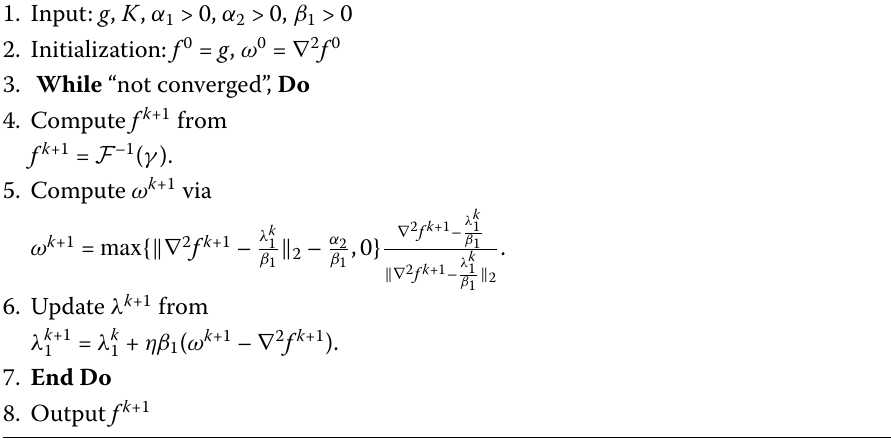
Algorithm 1 Alternating direction minimization method for solving subproblem